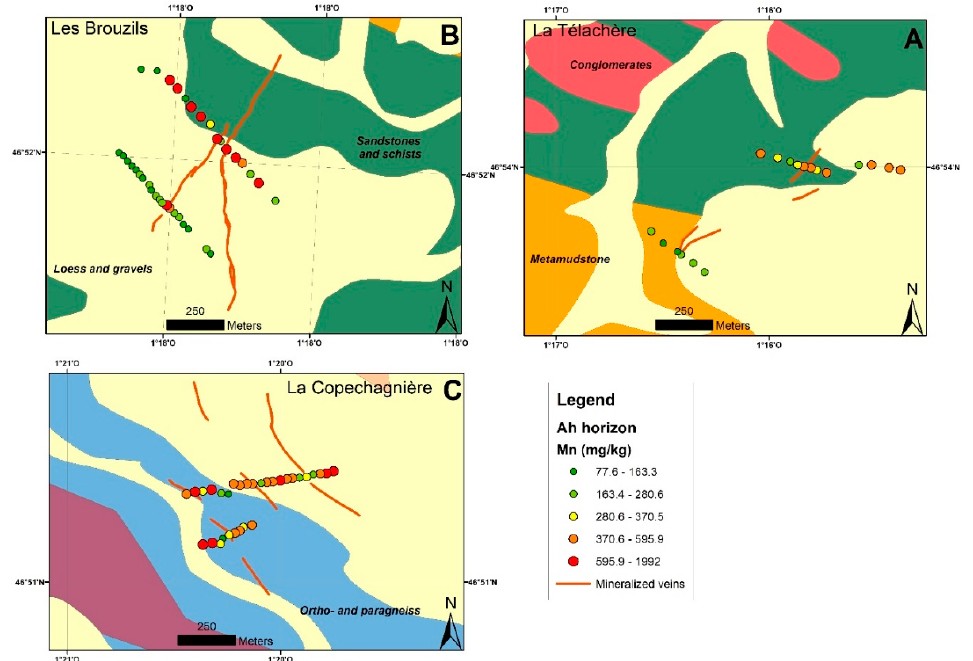
Figure 16. Mn map of Ah horizon samples (pXRF measurements in mg/kg). ( A ): La Télachère; ( B ): Les Brouzils; ( C ): La Copechagnière.